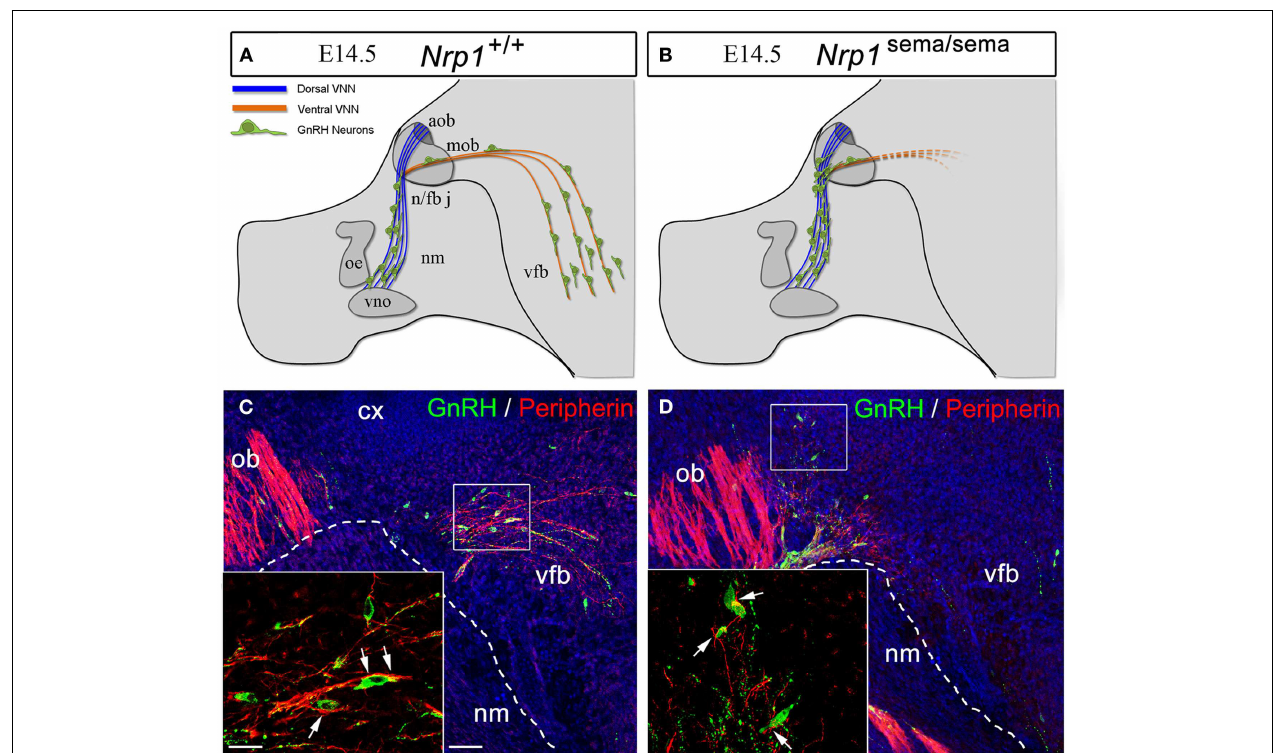
arrowheads) and the olfactory/vomeronasal marker, peripherin (red). Note the abnormal distribution of GnRH-immunoreactive cells in the Nrp-1 sema/sema mouse [ (D) , arrowheads]. Other abbreviations:VNN, vomeronasal nerve; cx, cerebral cortex; ob, olfactory bulb; nm, nasal mesenchyme; oe, olfactory epithelium; vno, vomeronasal organ; n/fb j, nasal/forebrain junction; aob, accessory olfactory bulb; mob, main olfactory bulb; vfb, ventral forebrain. Scale bars: (C,D) , 50 µ m; insets, 20 µ m. Adapted from Ref. (66), with